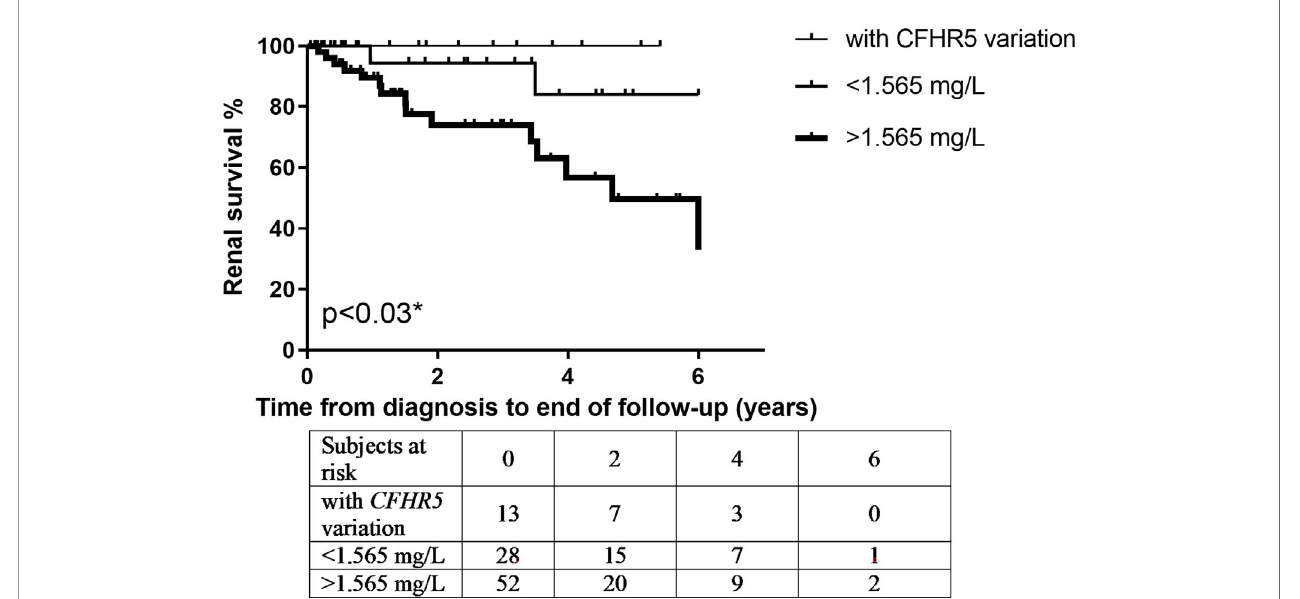
FIGURE 7 | Patients ’ renal survival according to their Factor H-related protein 5 (FHR-5) serum levels. * p-value was determined by log-rank test comparing patients with high and low FHR-5 serum levels.